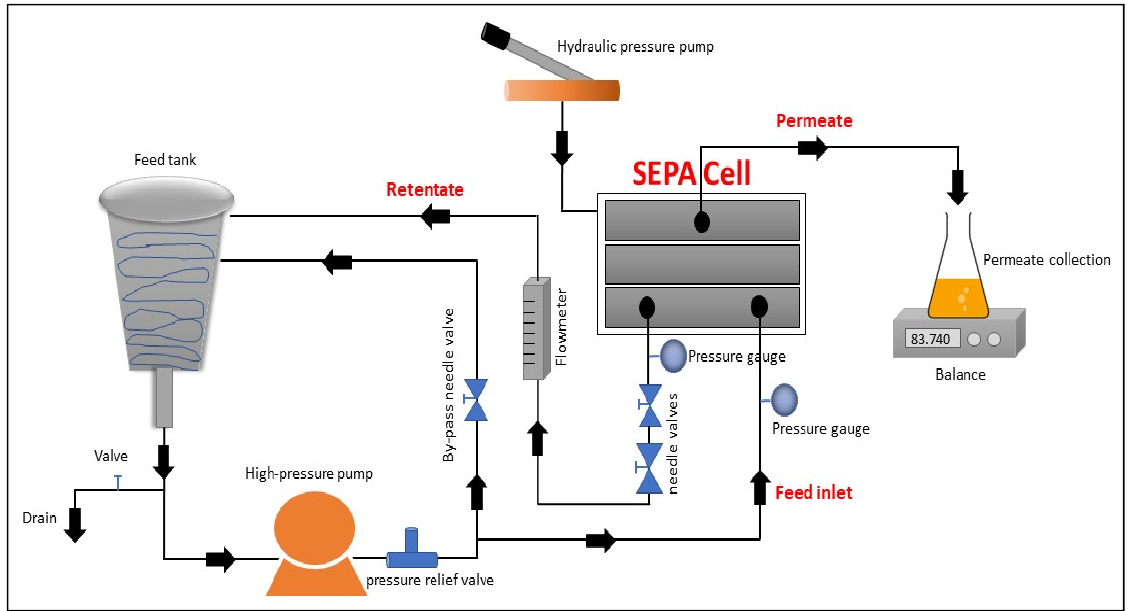
Figure 1. The schematic diagram of the membrane filtration apparatus. Furthermore, the experimental system was configured with the following parts: (1) a high-pressure feed pump (M-03 model, Wanner Engineering Inc., Minneapolis, MN, USA); (2) 5.7 L of stainless-steel conical feed tank (Sterlitech Corporation, Kent, WA, USA) to accommodate the feed and retentate returns from the system; (3) a high pressure relief